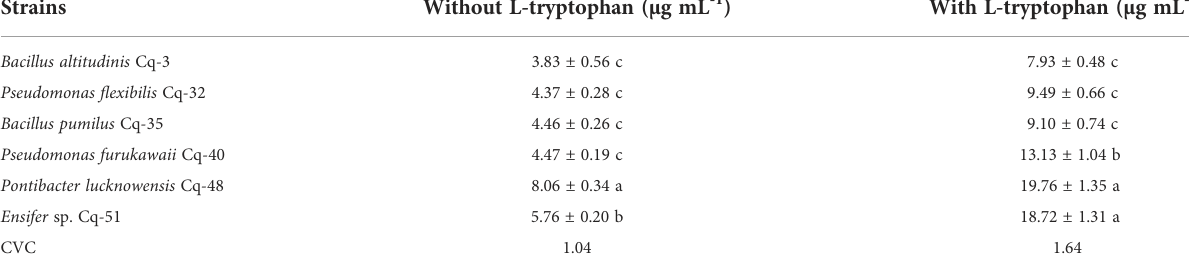
TABLE 5 Production of indole-3-acetic acid by phosphate solubilizing bacterial strains isolated from quinoa rhizosphere. Strains Without L-tryptophan (µg mL -1 ) With L-tryptophan (µg mL -1 ) Bacillus altitudinis